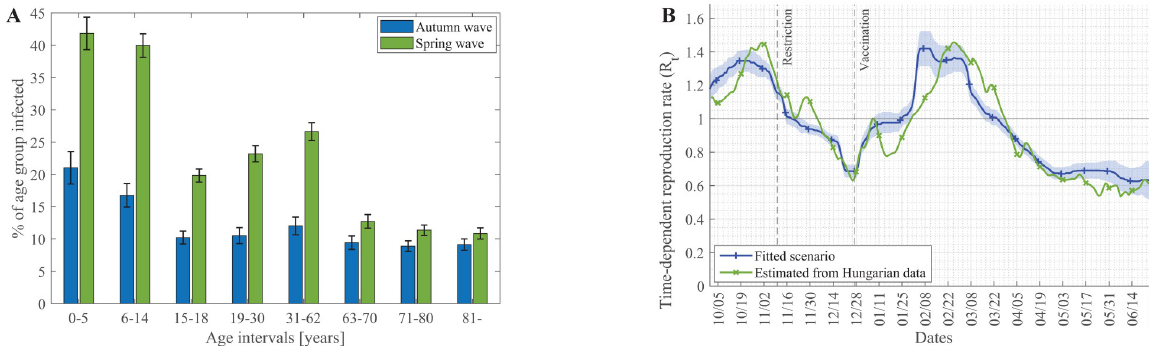
Fig 4. High infection rate of children and precise, effective reproduction number (R t ) emerge from the simulation results. (A) Percentage of the various age groups catching the infection during the autumn and the spring wave (error bars show the uncertainty of 20 simulations). (B) Changes in the reproduction number of the virus were calculated from the fitted scenario (Fig 1D) simulations (mean and std. of 30 simulations) plotted together with the empirical data of Hungary [22].